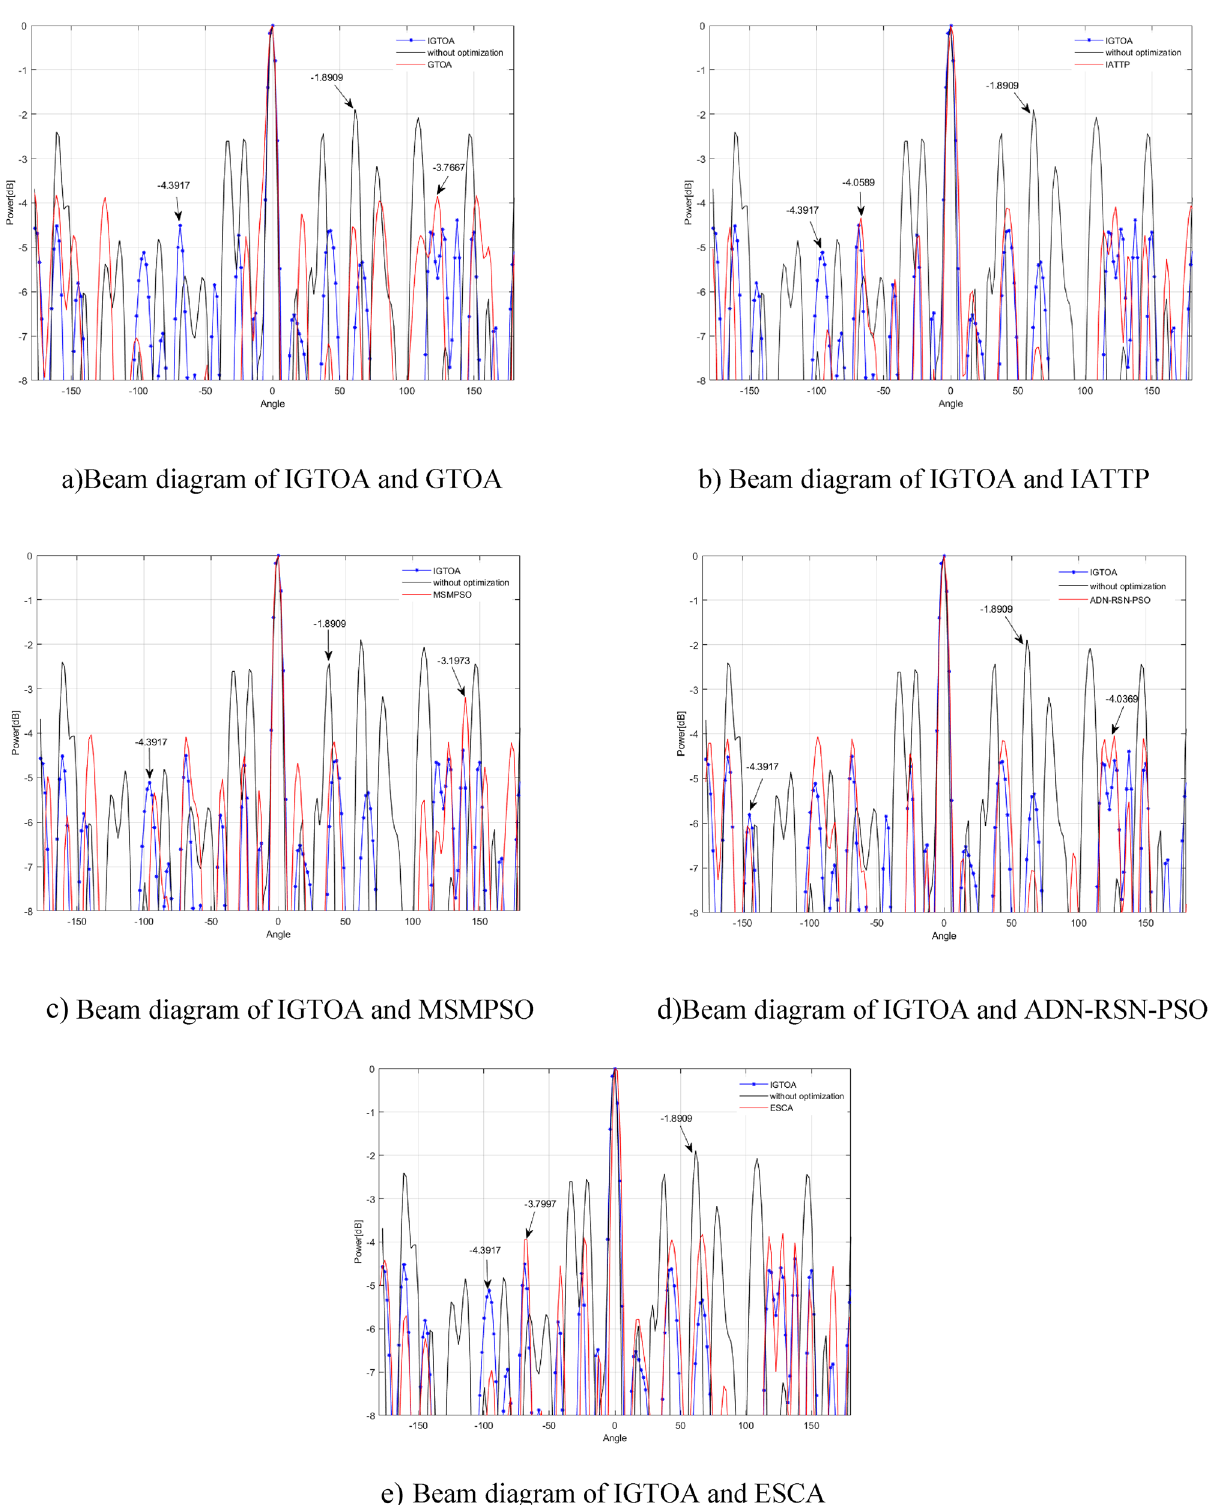
Figure 11. Beam map of IGTOA and each contrast algorithm in a rectangular coordinate